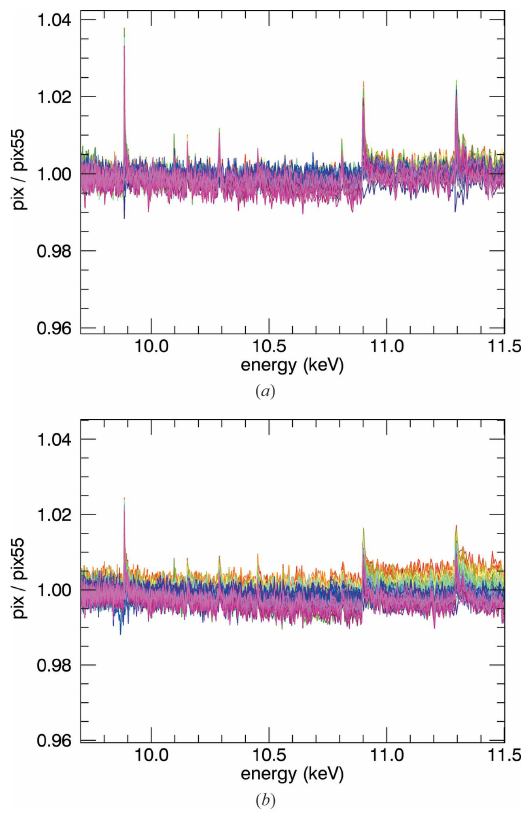
Figure 16 The spread of pixel intensities for the ( a ) 10 m m foil and ( b ) 50 m m foil across the whole above-edge energy range. Fluorescence intensities in each of the 100 detector elements, normalized by the upstream ion chamber counts at the absorption edge (9.671 keV), normalized to pixel #55 (close to the centre), across a broad range of energies. For the 10 m m foil, the spread is due to the low count rate and noise, i.e. the experimental uncertainty. For the 50 m m foil, there is a very clear divergence between pixels, caused by self-absorption. The intensity decreases as we move across the detector, as predicted by self-absorption (Fig. 14). SeAFFlux provides geometrical, self-absorption and mode (fluorescence, attenuation) corrections to convert fluorescence intensity into a quantitative ½ (cid:3)=(cid:2) (cid:2) (cid:8) , ready for analysis using traditional XAFS pe packages. SeAFFluX uses the experimental geometry to model the divergence and correct accordingly for each pixel, rather than just averaging the